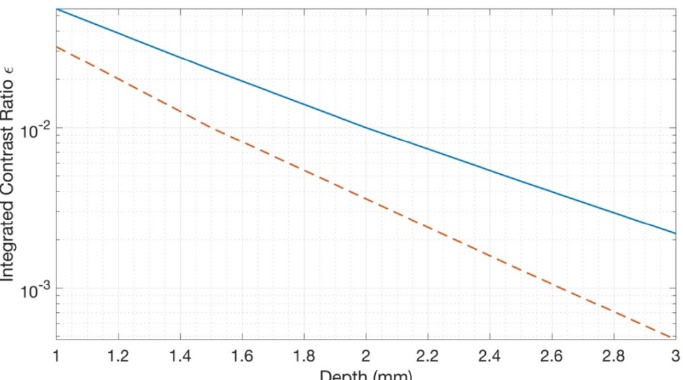
Figure 3. Imaging of large blood vessels. Integrated contrast ratio as a function of the vessel depth (1–3mm) for several blood content concentrations: c Hb =0.01 and 0.1 (solid blue and dashed red lines, respectively). SO 2 was set to 70%. The normal water content ( c 0 =0.7) was selected as a background. The cross-section of the vessel was set to S =0.1mm 2 .